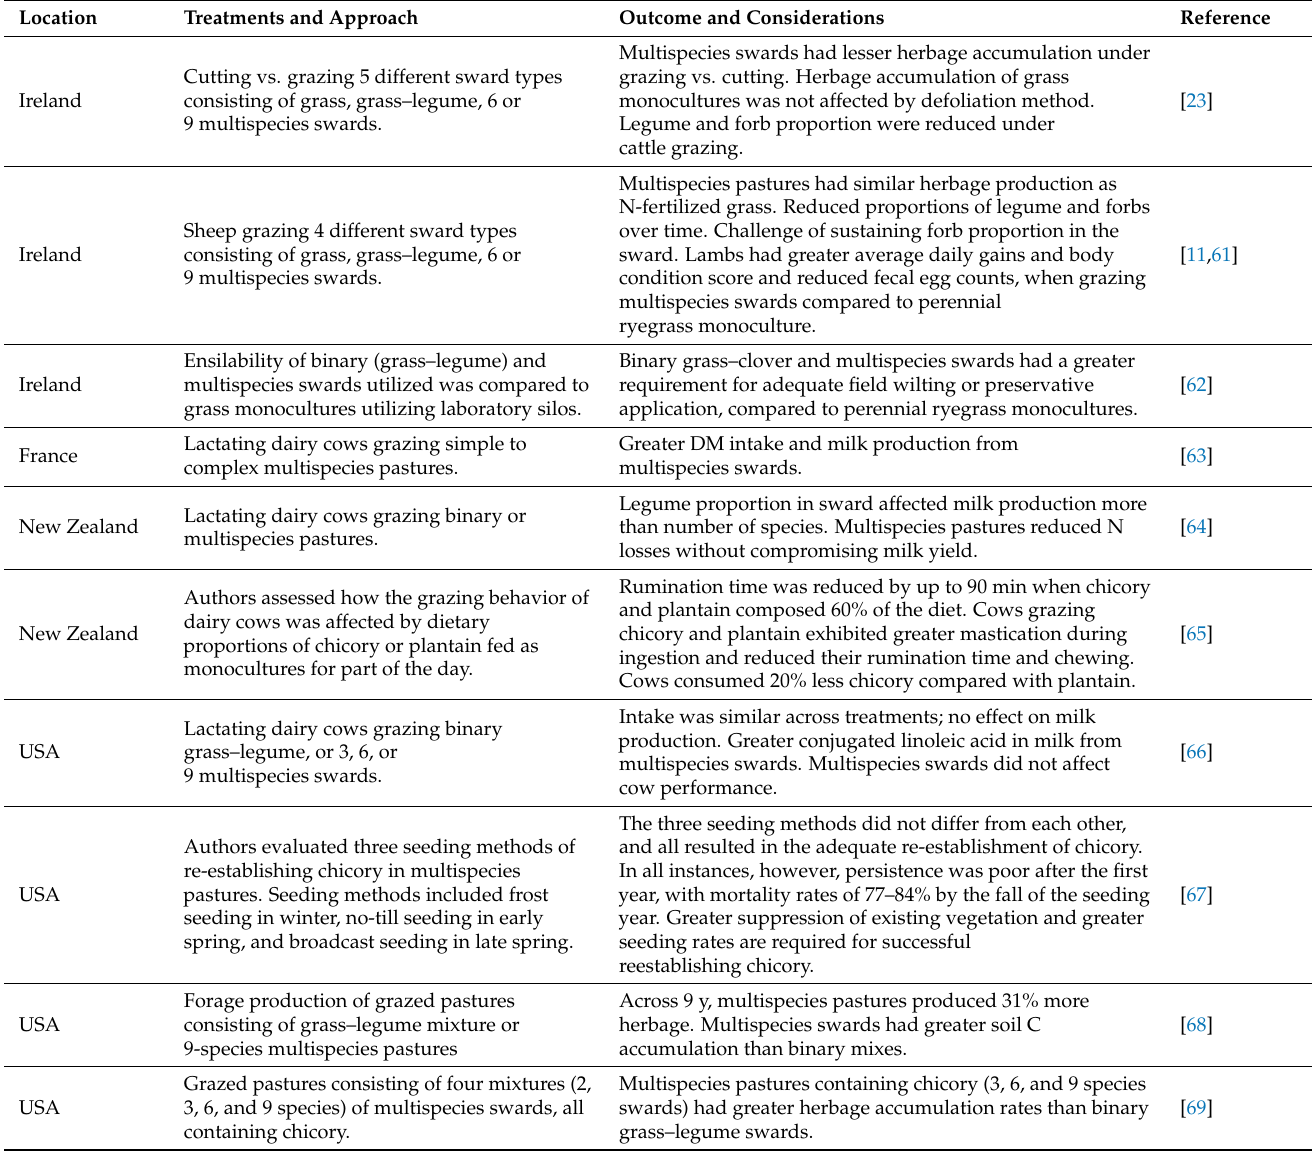
Table 1. Selected studies describing the use of multispecies swards in temperate regions.